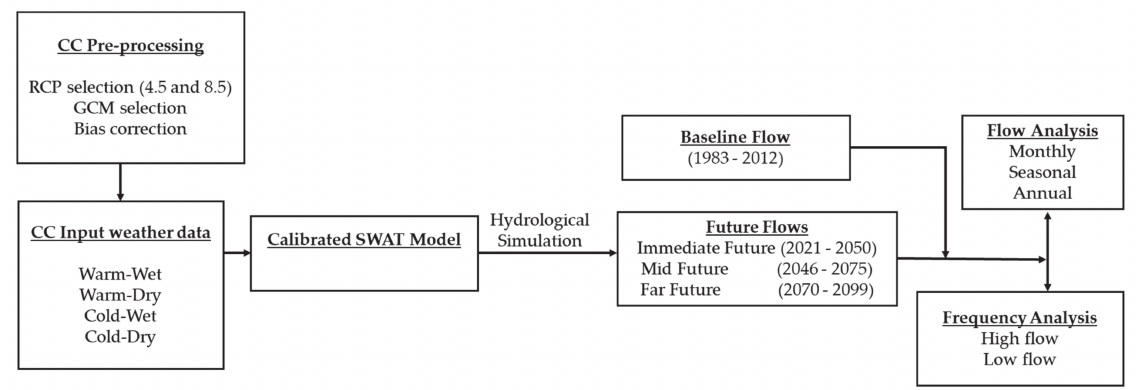
Figure 1. Overall methodological